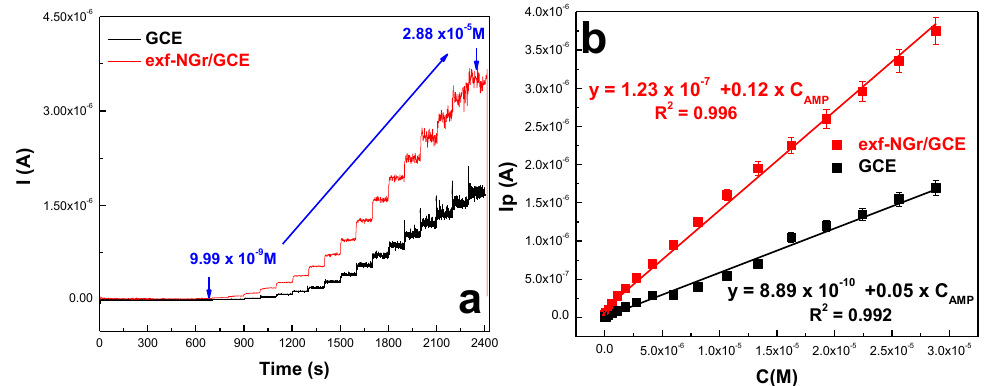
Figure 8. ( a ) Amperometric curves recorded with exf-NGr/GCE (red; +0.52 V applied potential) and GCE (black; +0.7 V applied potential) in pH 4.4 supporting electrolyte, after the addition of AMP from 10 −4 M stock solution; the concentration range was from 9.99 × 10 −9 to 2.88 × 10 −5 M AMP; ( b ) the corresponding calibration plots for exf-NGr/GCE (red) and GCE (black), using background subtracted signals.